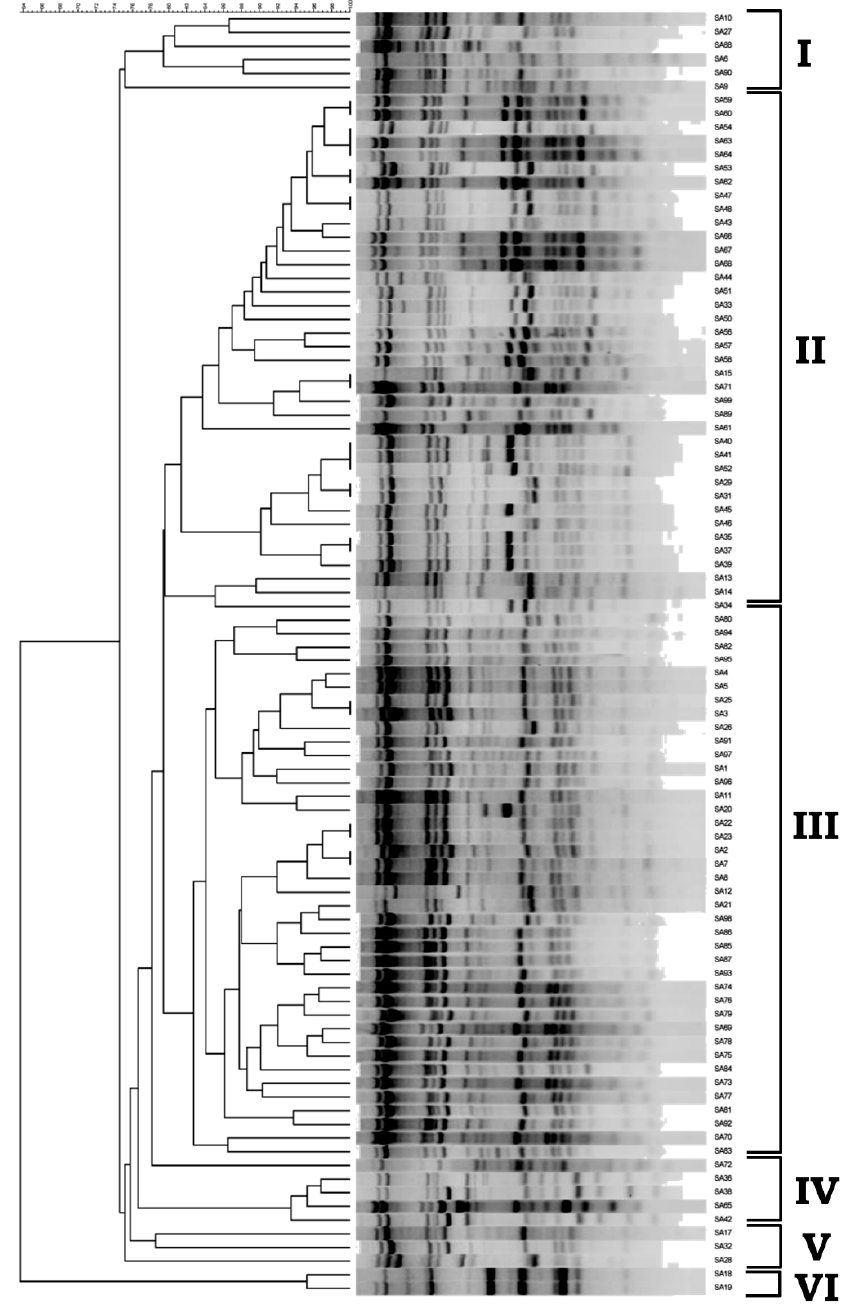
Figure 1. UPGMA clustering of the random amplified polymorphic DNA (RAPD) profiles of S.